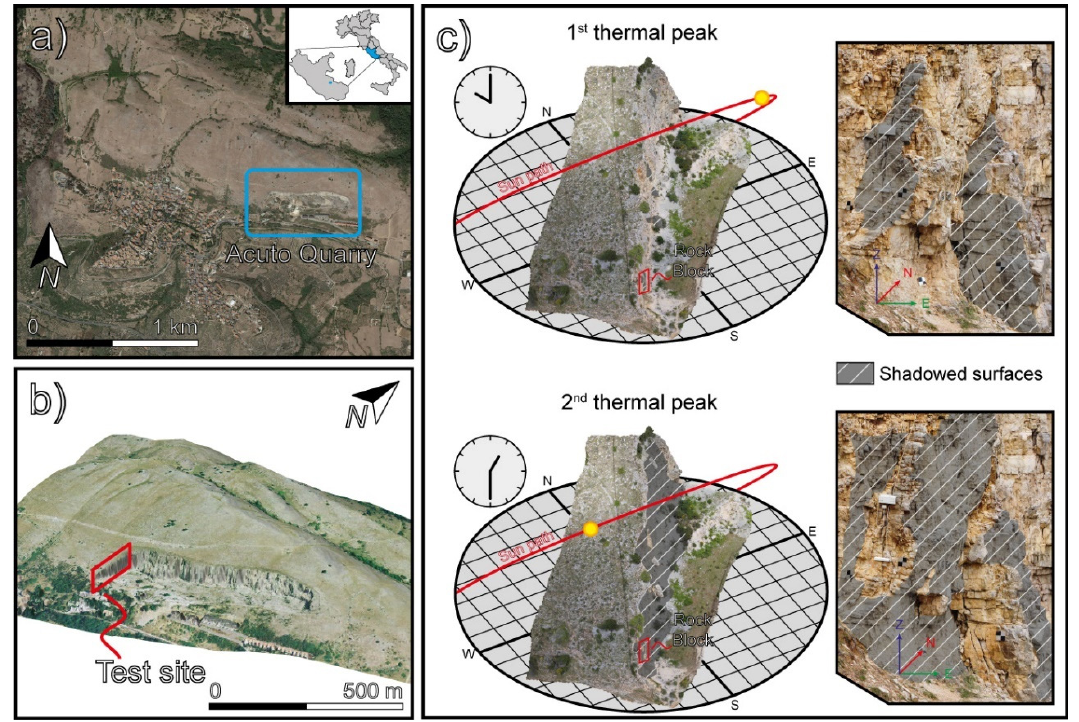
Figure 1. ( a ) Satellite view and ( b ) LiDAR model of the abandoned quarry within the municipality of Acuto (Lat: 41°47 ′ 30.94 ″ N, Lon: 13°10 ′ 23.94 ″ E) where the experimental test site was implemented in 2016. ( c ) A simplified sketch representing the correlation between solar path trajectories and the exposed surfaces of the rock wall is proposed.